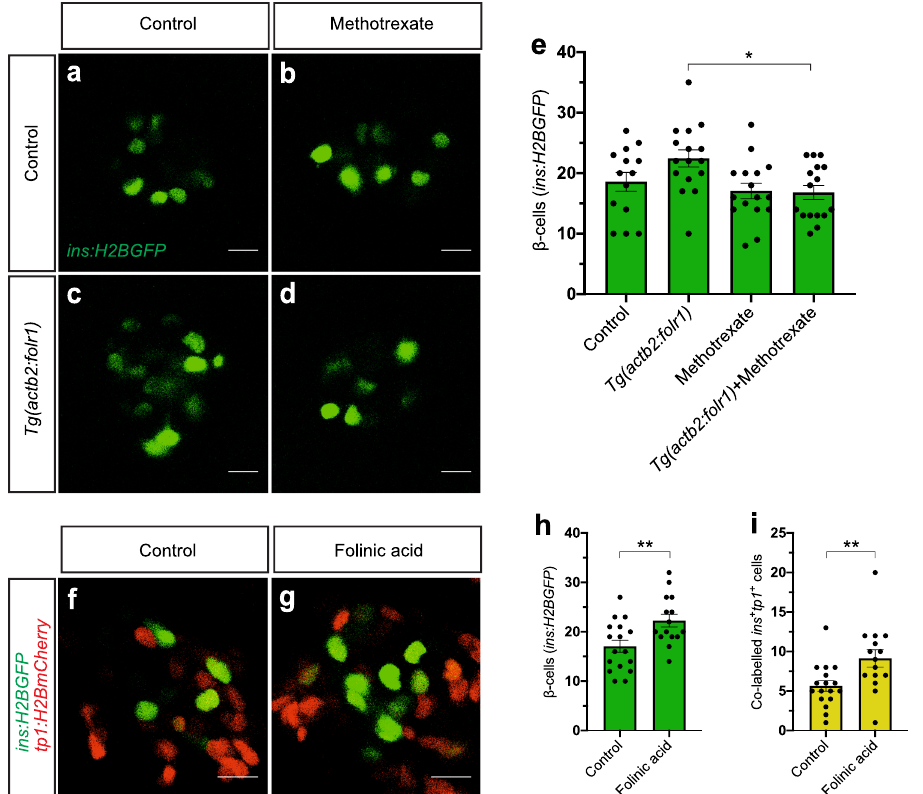
Fig. 4 One-carbon metabolism stimulates β -cell regeneration. a – e Single-plane confocal images of control ( a ), methotrexate-treated ( b ), Tg(actb2:folr1) ( c ) and Tg(actb2:folr1) cotreated with methotrexate ( d ) islets following 2 days of β -cell regeneration. Quanti fi cation showed that the number of regenerating β -cells upon Tg(actb2:folr1) overexpression was reduced to the baseline level after treatment with methotrexate ( e ). Scale bar, 10 μ m. n = 14 control, n = 16 methotrexate-treated, n = 16 Tg(actb2:folr1) , and n = 16 Tg(actb2:folr1) cotreated with methotrexate biologically independent zebra fi sh larvae were used for the quanti fi cation of β -cells. Data are presented as mean values ± SEM. One-way ANOVA was used to assess signi fi cance followed